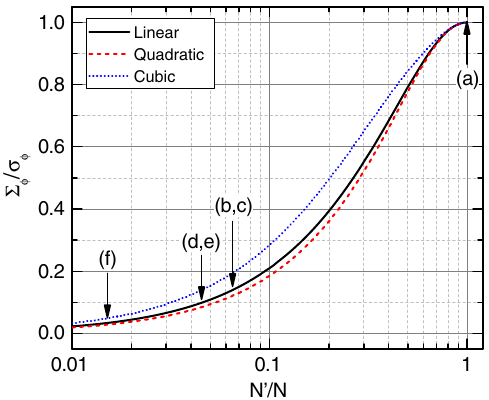
arrows with alphabets. In the practical conditions (b – f), the